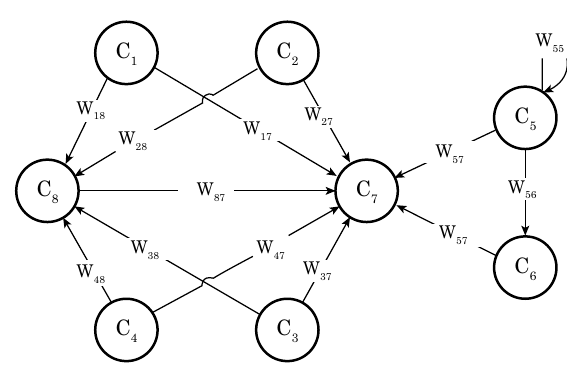
Fig. 1. Typical structure of an FCM (Salmeron 2012: 3706).